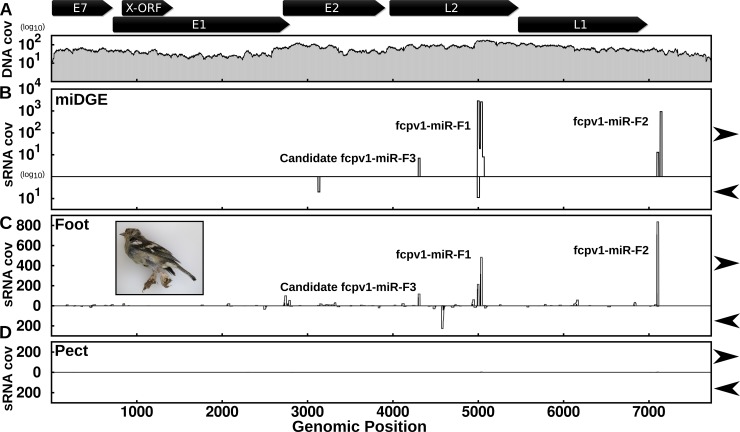
FcPV1 miRNAs are detected in vivo during viral infection.(A) DNA-seq coverage for FcPV1 genome in miDGE library is plotted on log10 scale on the y-axis. The x-axis corresponds to position in the genomic sequence. A schematic of the FcPV1 gene organization taken from NCBI reference sequence NC_004068 is provided at the top. (B) Small RNA-seq coverage for FcPV1 genome in miDGE library is plotted on log10 scale on the y-axis. Values above the x-axis correspond to the forward strand and those below correspond to the reverse strand. The x-axis corresponds to position in the genomic sequence. Peaks corresponding to the newly identified miRNA genes are labeled. (C) Plot of read coverage and start sites for reads mapping to the FcPV1 genome in library prepared with RNA from infected chaffinch leg lesion samples. On the y-axis, coverage is plotted with gray lines and read start counts are plotted with black impulses. Values above the x-axis represent the forward strand and those below represent reads mapping to the negative strand. Genomic position is indicated on the X-axis. Peaks corresponding to the newly identified miRNA genes (fcpv1-miRs-F1 & F2) are labeled as well as the lower expressed candidate miRNA “fcpv1-miR-F3”. The inset photograph is of one of the chaffinches with characteristic leg lesions used in preparation of the small RNA-seq libraries. (D) Plot of read coverage and start sites for reads mapping to the FcPV1 genome in library prepared with RNA from chaffinch pectoral muscle samples. On the y-axis, coverage is plotted with gray lines and read start counts are plotted with black impulses. Values above the x-axis represent the forward strand and those below represent reads mapping to the negative strand. Genomic position is indicated on the X-axis. Peaks corresponding to the newly identified miRNA genes are labeled.